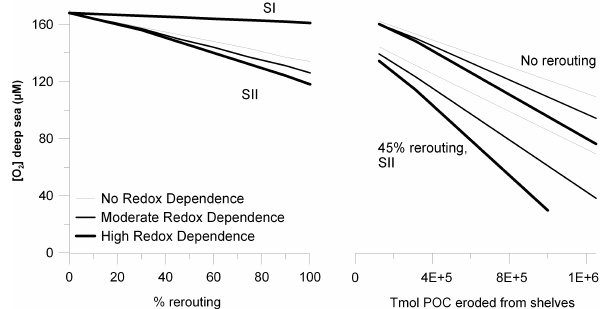
Fig. 2. Effect of submarine river canyon formation (and rerouting of particulate material) and shelf erosion on deep-sea oxygen con- centrations at the last glacial maximum (LGM). Left hand side plot: rerouting of particulate material past the coast via submarine river canyons. Light gray lines represent a system where organic and authigenic P burial are not redox dependent. Dark grey lines rep- resent a moderate redox dependence (25% in organic P, 50% in au- thigenic P) as described in Slomp and Van Cappellen (2007). Black line represents high redox dependent burial of P (75% in organic P, 90% in authigenic P) as implemented in Tsandev and Slomp (2009) for anoxic settings. Both rerouting scenarios detailed in Fig. 1 are plotted. Right hand side plot: a shelf erosion flux is applied as an event in the late glacial stage (50kyr) leading to the LGM. Results are shown both for shelf erosion without river canyon rerouting and with rerouting according to scenario SII. The results for SI lie within the plotted